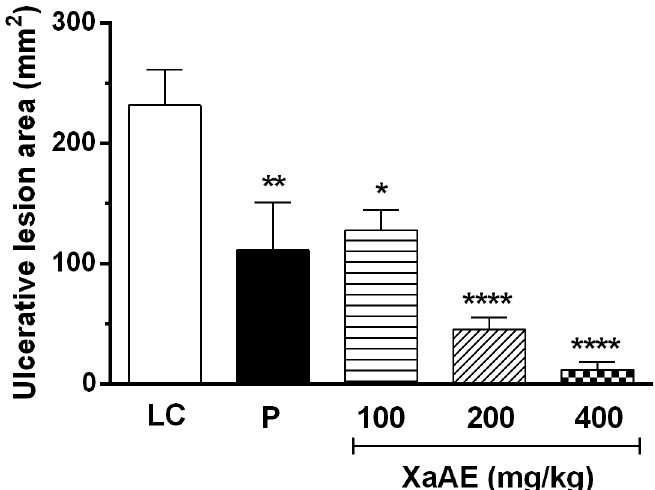
Figure 5. Gastroprotective effect of the aqueous extract of X. americana (XaAE ) stem bark on acidified ethanol-induced (0.3 M HCl/60% ethanol, 1 mL, orally) gastric lesions in Wistar rats. Animals received 0.9% NaCl solution (lesioned control, LC, 10 mL/kg, orally), pantoprazole (P, 40 mg/kg, orally) or XaAE (100, 200 and 400 mg/kg, orally). Results were expressed as mean ± SEM (6–7 animals/group). Statistically different when compared to the lesioned control group (ANOVA, followed by Dunnett’s multiple comparisons test, * p ˂ 0.02, ** p < 0.005, **** p < 0.0001).